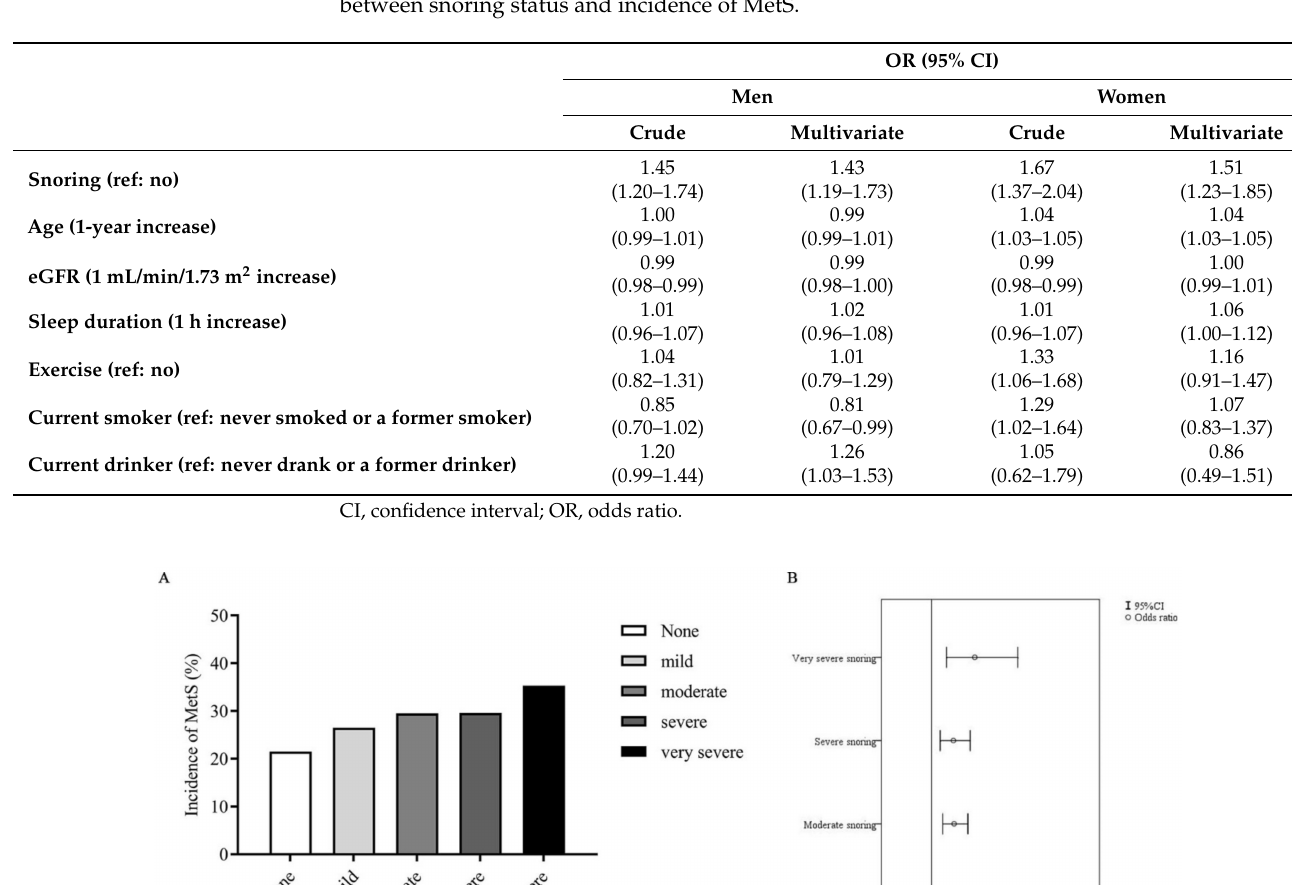
Table 5. ORs (95% CIs) for incidence of MetS at follow-up (gender subgroup analysis); relationship between snoring status and incidence of MetS.